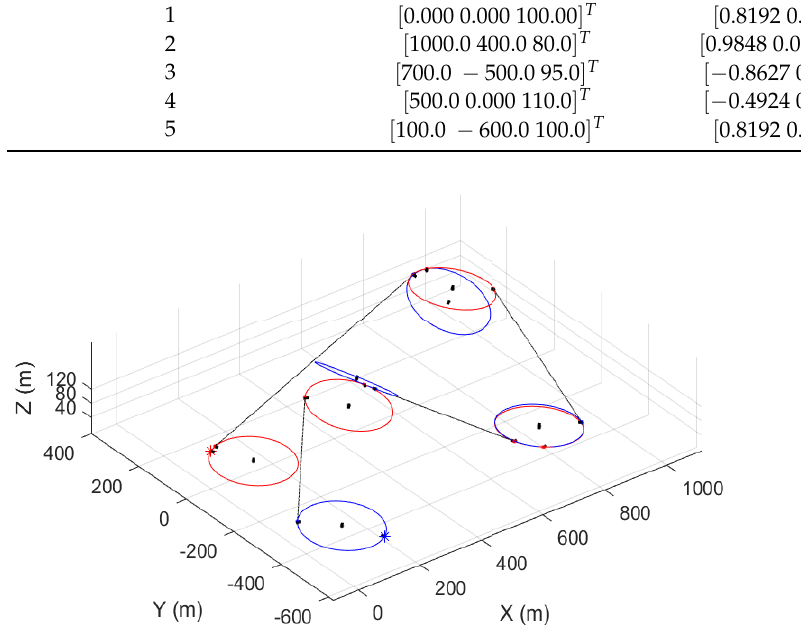
Figure 5. A 3-dimensional Dubins path constructed by circles and lines for the five